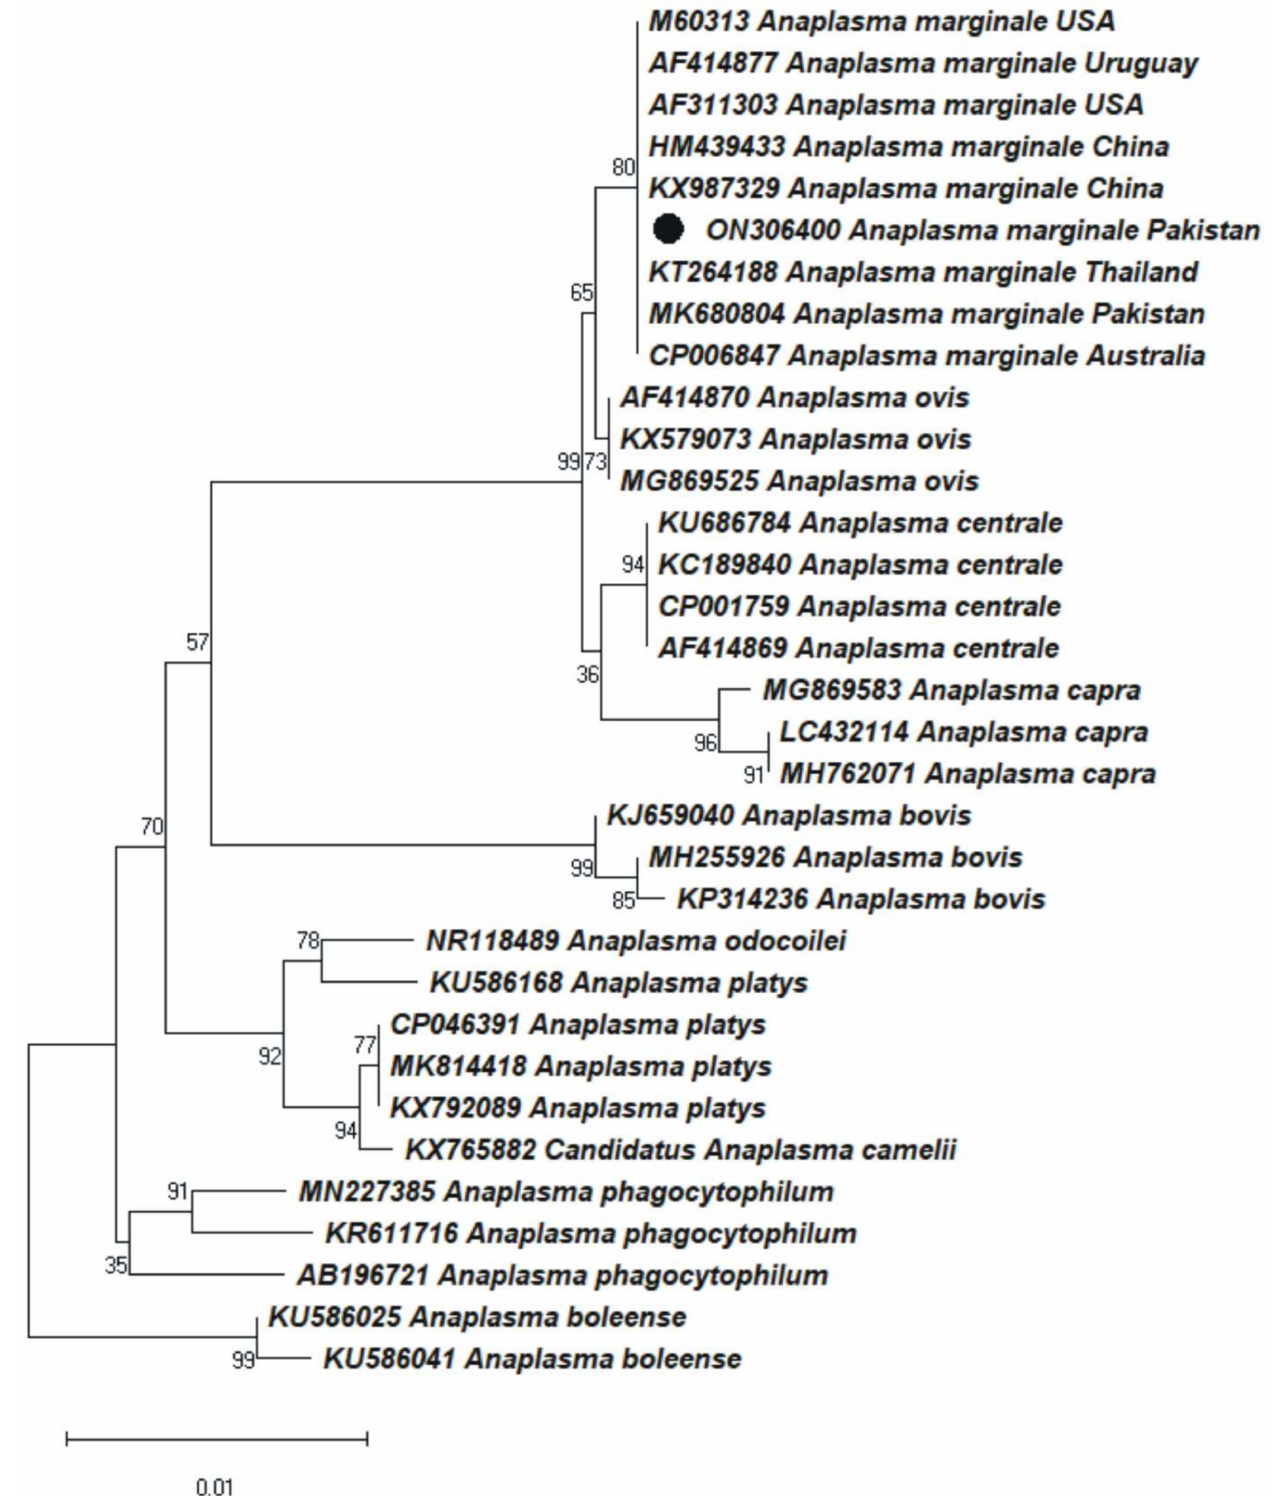
Figure 2. The maximum likelihood phylogenetic tree of Anaplasma marginale was constructed based on a partial 16S rDNA sequence. Anaplasma boleense 16S rDNA sequences were used as an outgroup. The obtained sequence is represented with a black dot